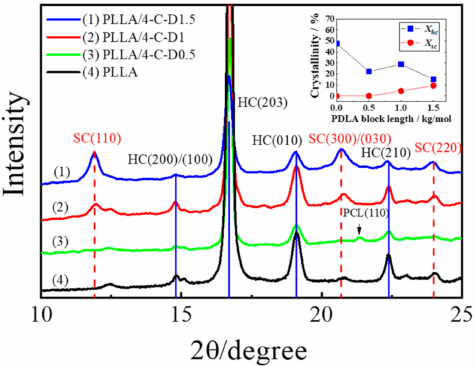
Figure 2. WAXD curves and crystallinities of PLLA and the PLLA / 4-C-D blends with di ff erent PDLA block lengths after isothermal crystallization at 140 ◦ C for 8